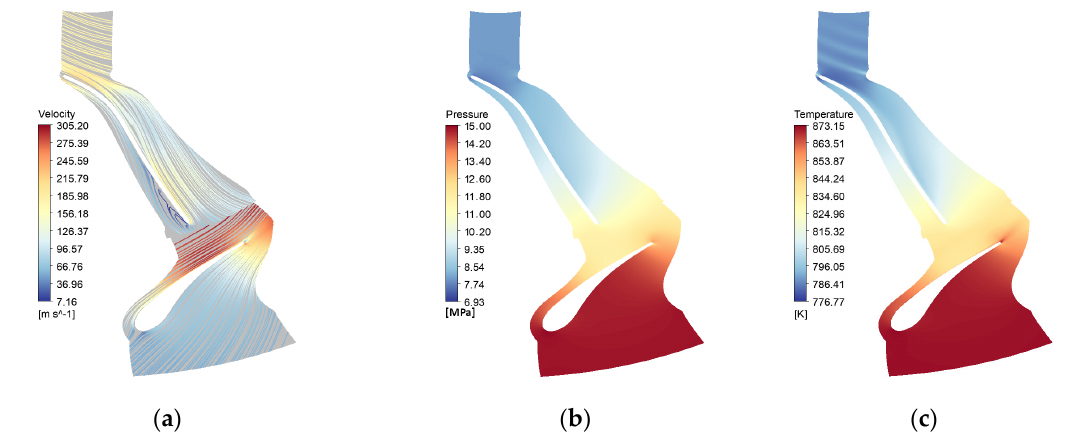
Figure 5. Key parameter distributions of 50% blade height section under design conditions: ( a ) limiting streamline; ( b ) pressure distribution; ( c ) temperature distribution.